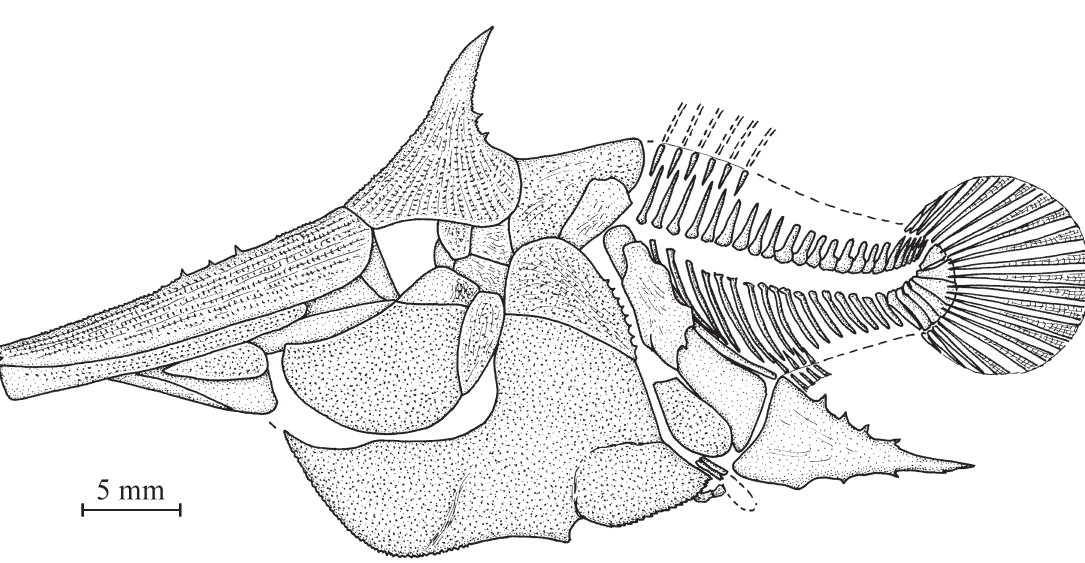
Fig. 18. Rostropycnodus gayeti gen. et sp. nov., paratype CLC S-337. Reconstruction based on the three specimens. Body scales omitted.